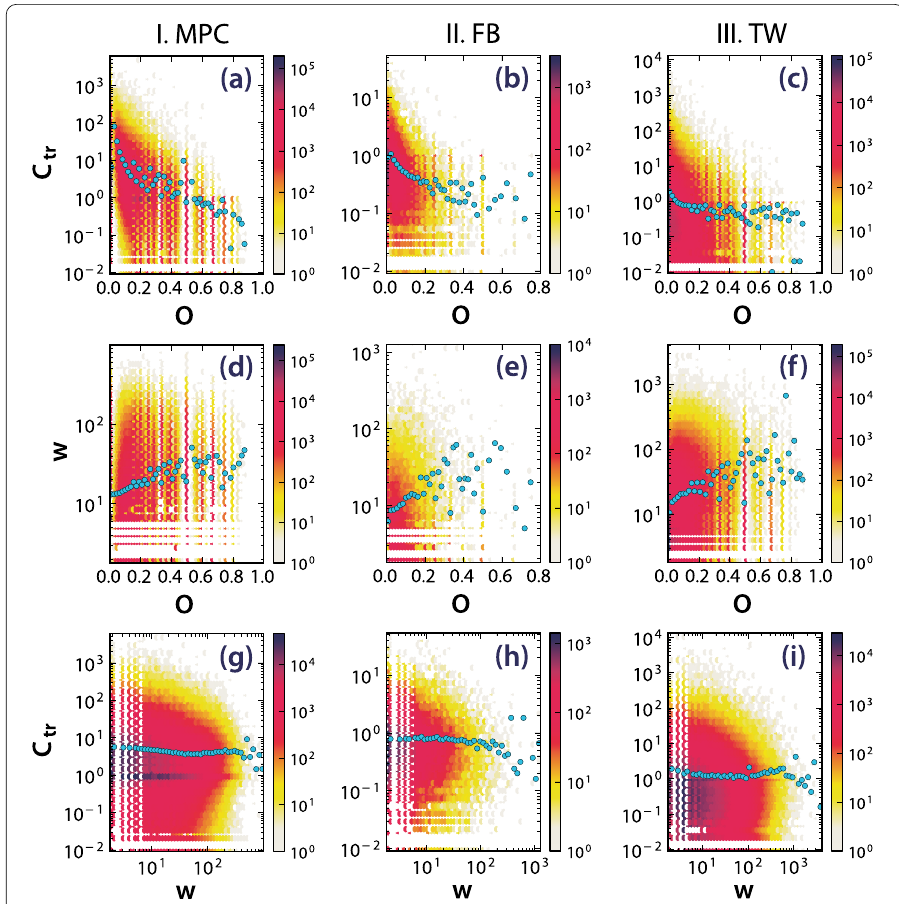
Figure 3 Correlations between transmission centrality C tr and overlap O (( a )–( c )), dyadic tie strength w and overlap O (( d )–( f )), and between transmission centrality C tr and dyadic tie strength w values (( g )–( i )) of links in the MPC (( a ), ( d ), ( g )), FB (( b ), ( e ), ( h )), and TW (( c ), ( f ), ( i )) networks. The colors of the binned heat maps assign the distribution of links with the given pair of tie strength values, while blue symbols show their average over the y -axis as a function of the x -axis values (quantitative measures of correlations between link properties can be found in Table 1)